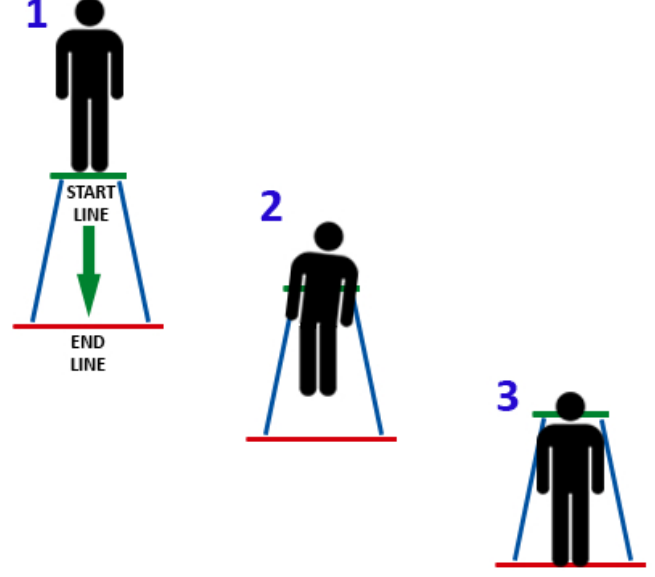
Figure 4. Steps to be performed during the BDRehab exercise: (1) to start in an upright posture; (2) to go along five-meter long straight line; and (3) to stop at the finish line and maintaining the upright